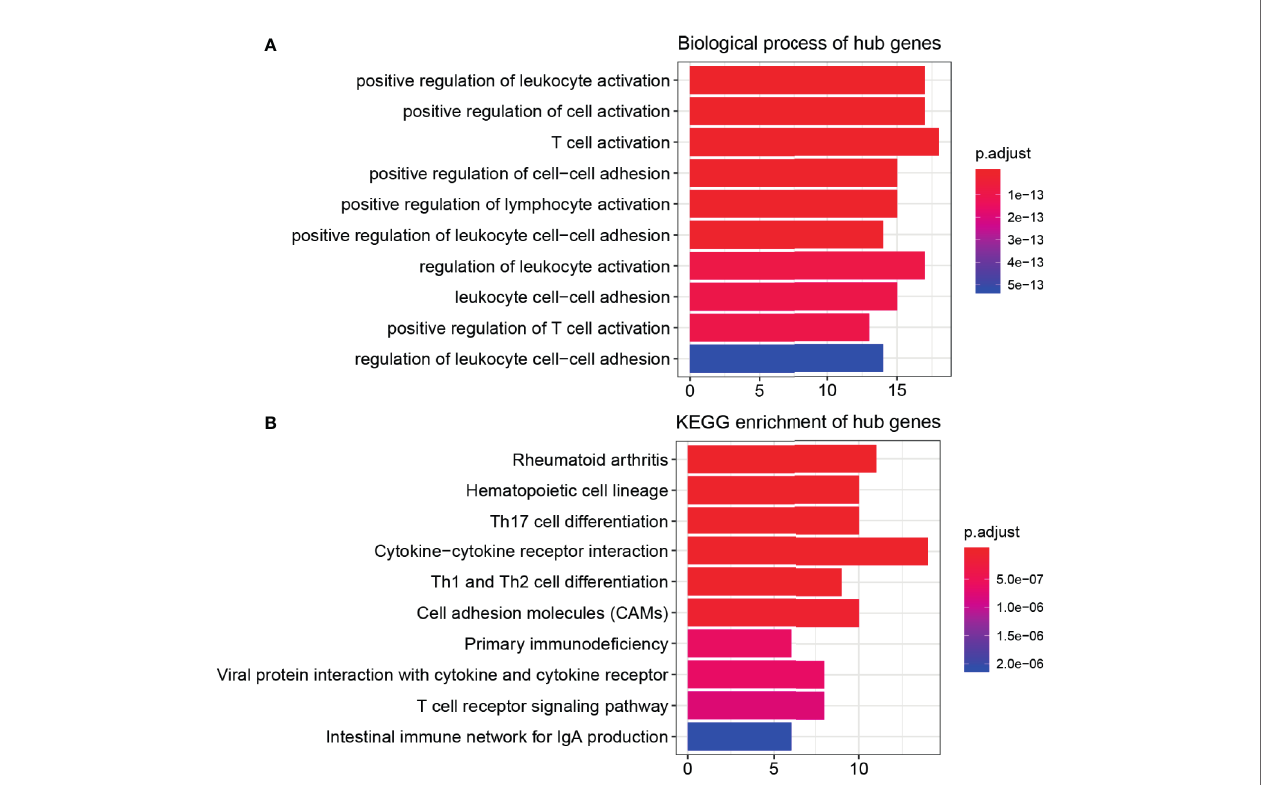
FIGURE 3 | Function enrichment analysis, PPI network, and GEPIA. (A) GO analysis of hub genes in key modules. (B) KEGG pathway enrichment of hub genes in key